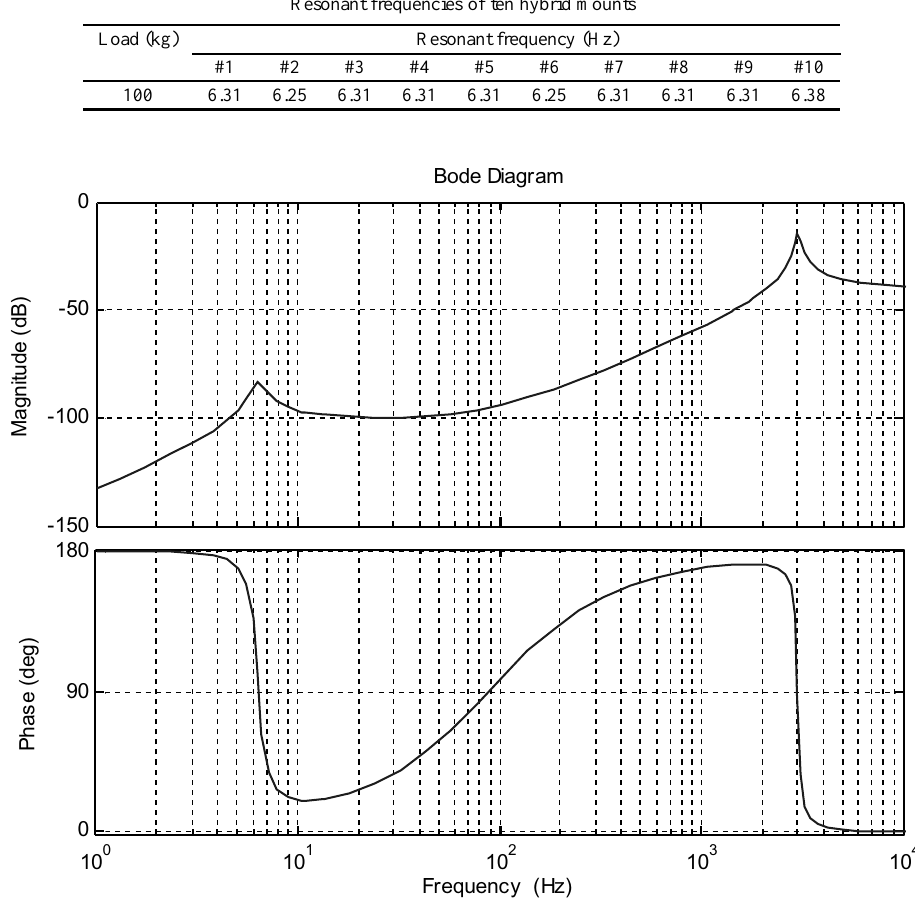
Fig. 9. Bode plot for piezostack actuating control force to equipment